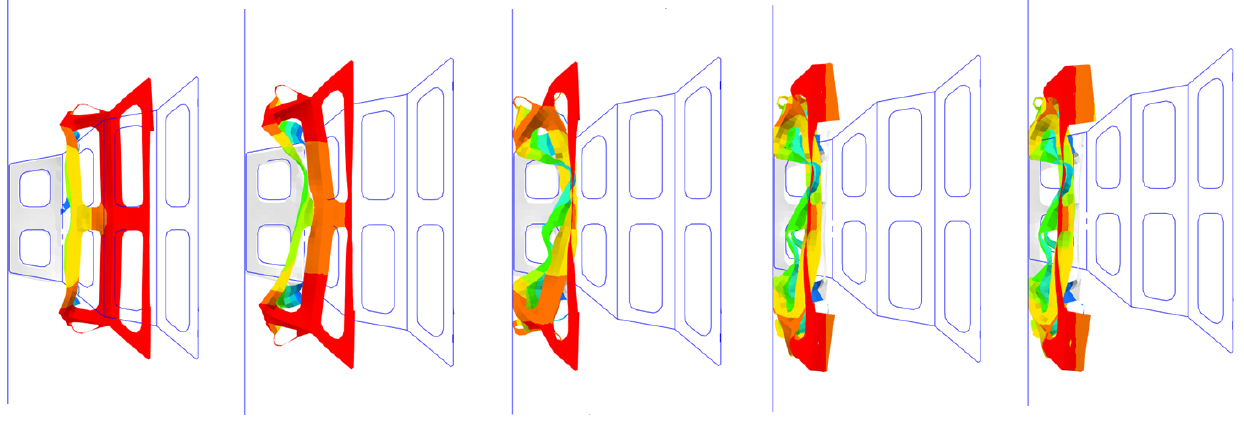
Figure 22. Different positions of the deformed impact attenuator at the following times: 0.1 s; 0.2 s; 0.3 s; 0.4 s; 0.5 s.